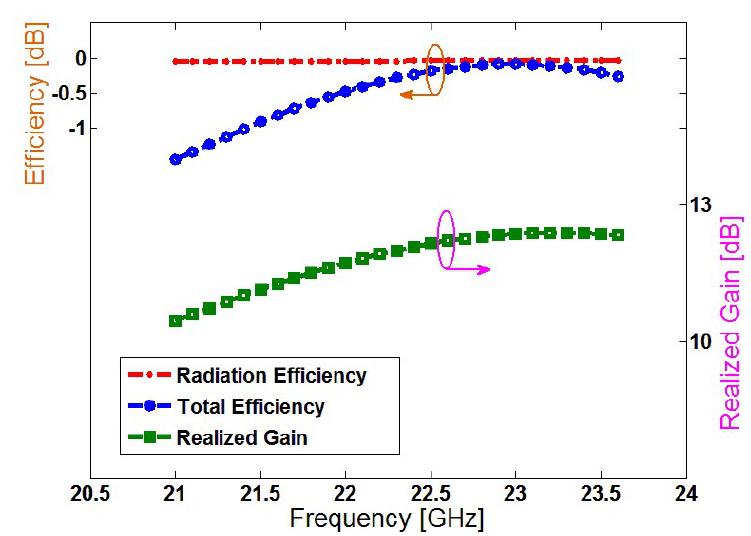
Figure 12. Fundamental radiation parameters over the array impedance bandwidth.